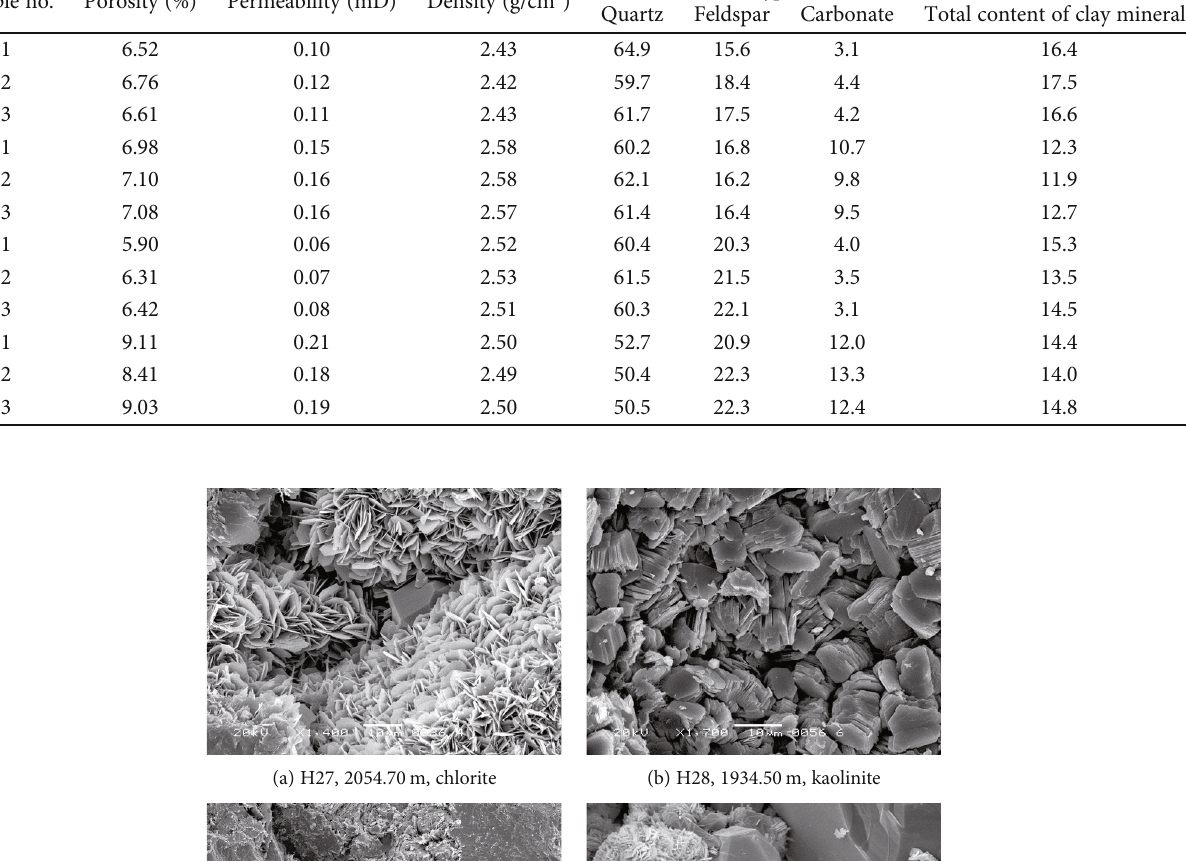
Table 1: Properties and mineral compositions of the studied tight sandstone core samples. Sample no.